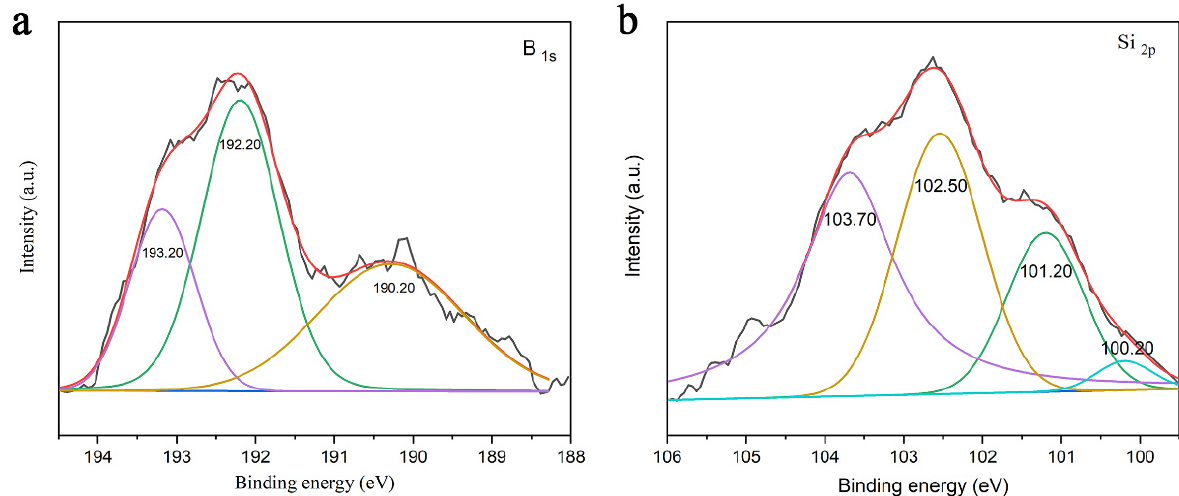
Figure 10. B 1s spectra ( a ) and Si 2p spectra ( b ) of products on the surface of the ablated SiBCN–phenolic/C composites.